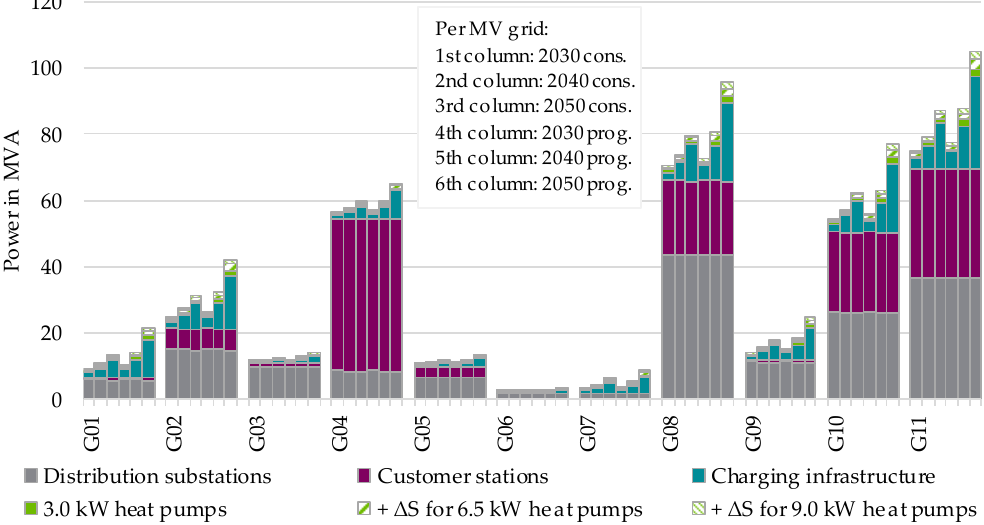
Figure 8. Load development for eleven medium voltage grids for the two development scenarios over the years 2030, 2040 and 2050 based on [59].